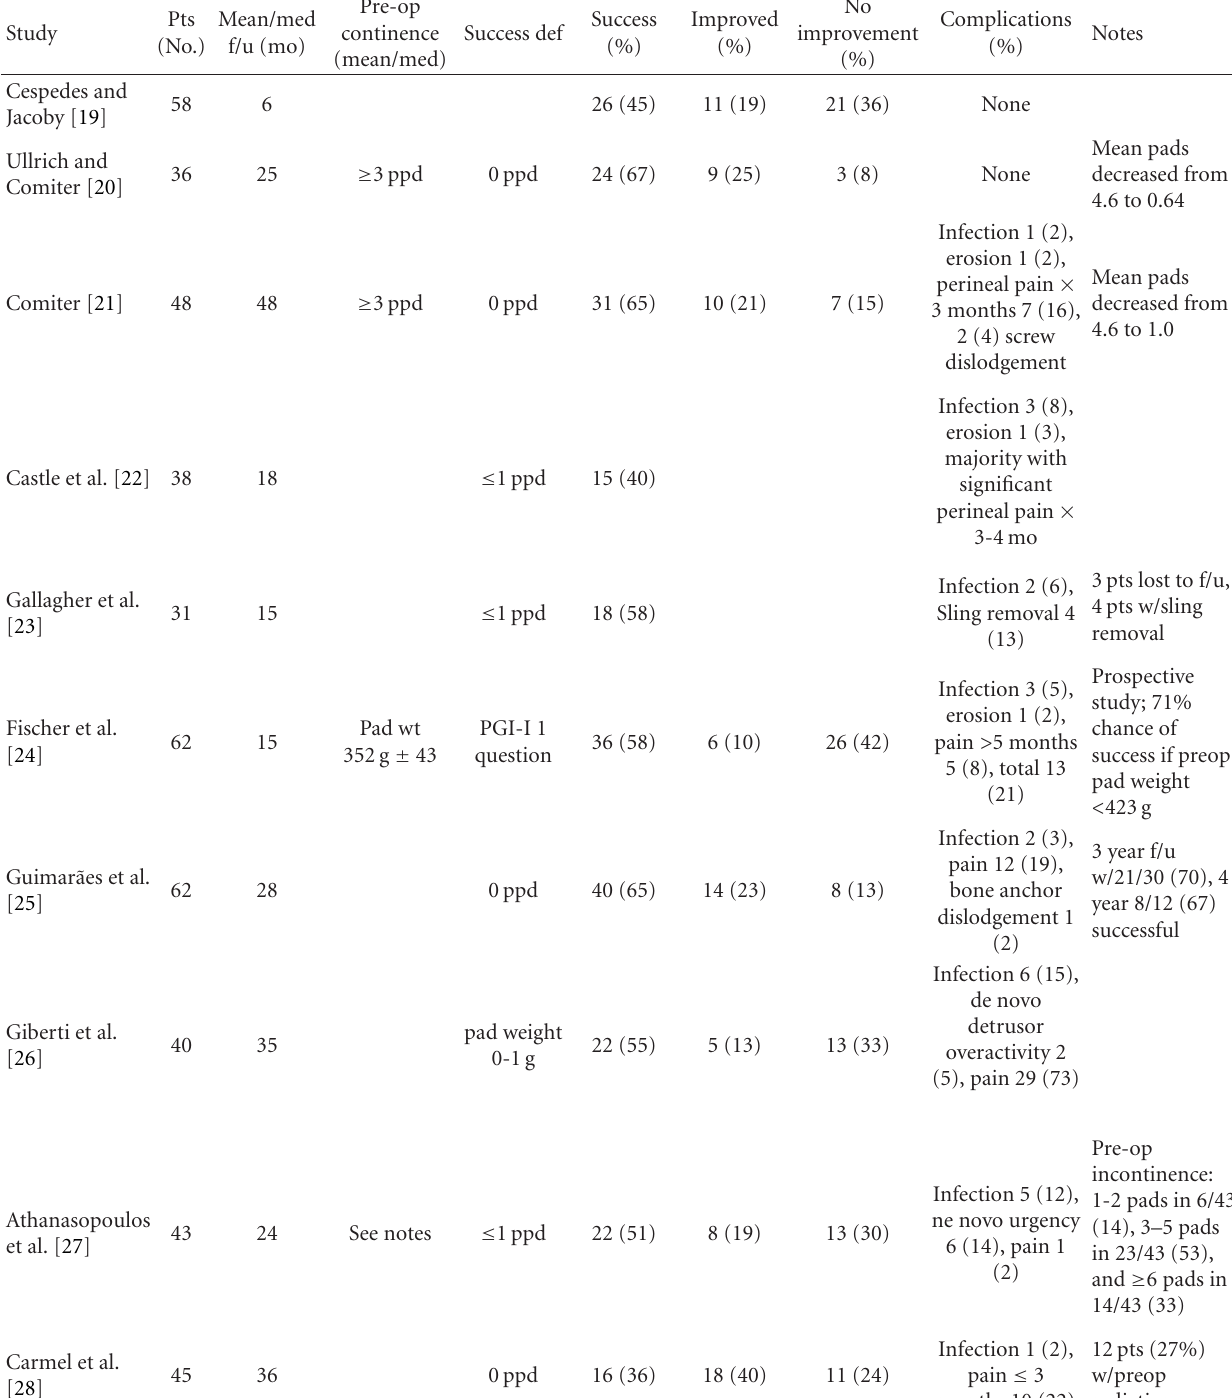
Table 1: Comparison of results of bone anchored sling placement in adult males with